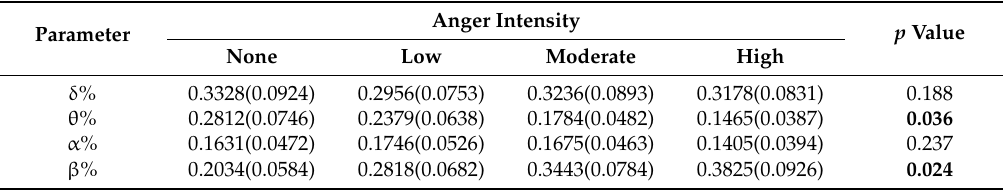
Table 1. Statistical (mean (std.)) and significance analysis of EEG spectral features between different anger intensity from all subjects. (The bold face number means the differences are